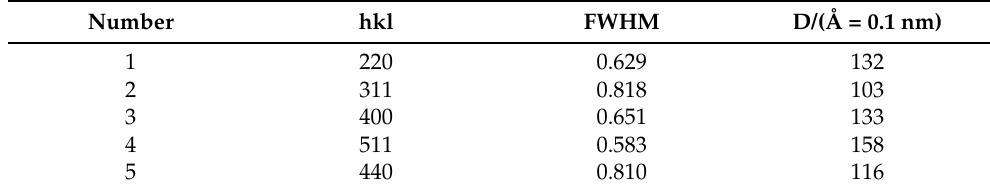
Table 1. The crystal plane index, half-width, and grain size of the sample obtained with JADE software.